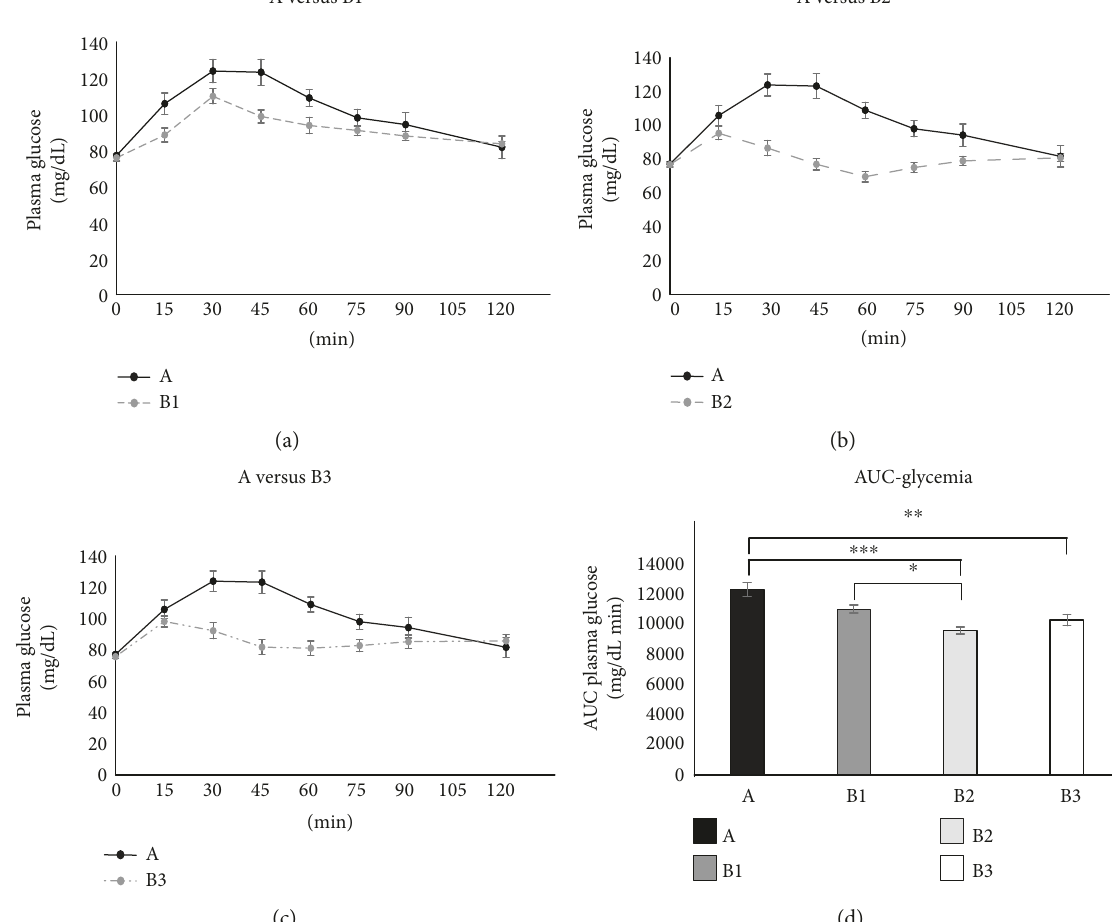
Figure 1: The time courses of glucose concentrations following breakfasts (a) B1, (b) B2, and (c) B3, respectively. For the sake of comparison, each of the three panels also displays the time course of glucose concentration measured after glucose ingestion (black line, glucose). (d) The AUC of glycemia for each test. ∗ p < 0 05 ; ∗∗ p < 0 01 ; ∗∗∗ p < 0 001